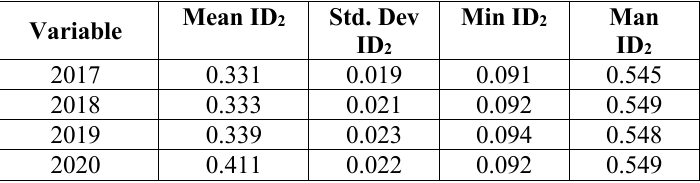
Table 9. Descriptive statistics ID (1;2) index from 2017 to